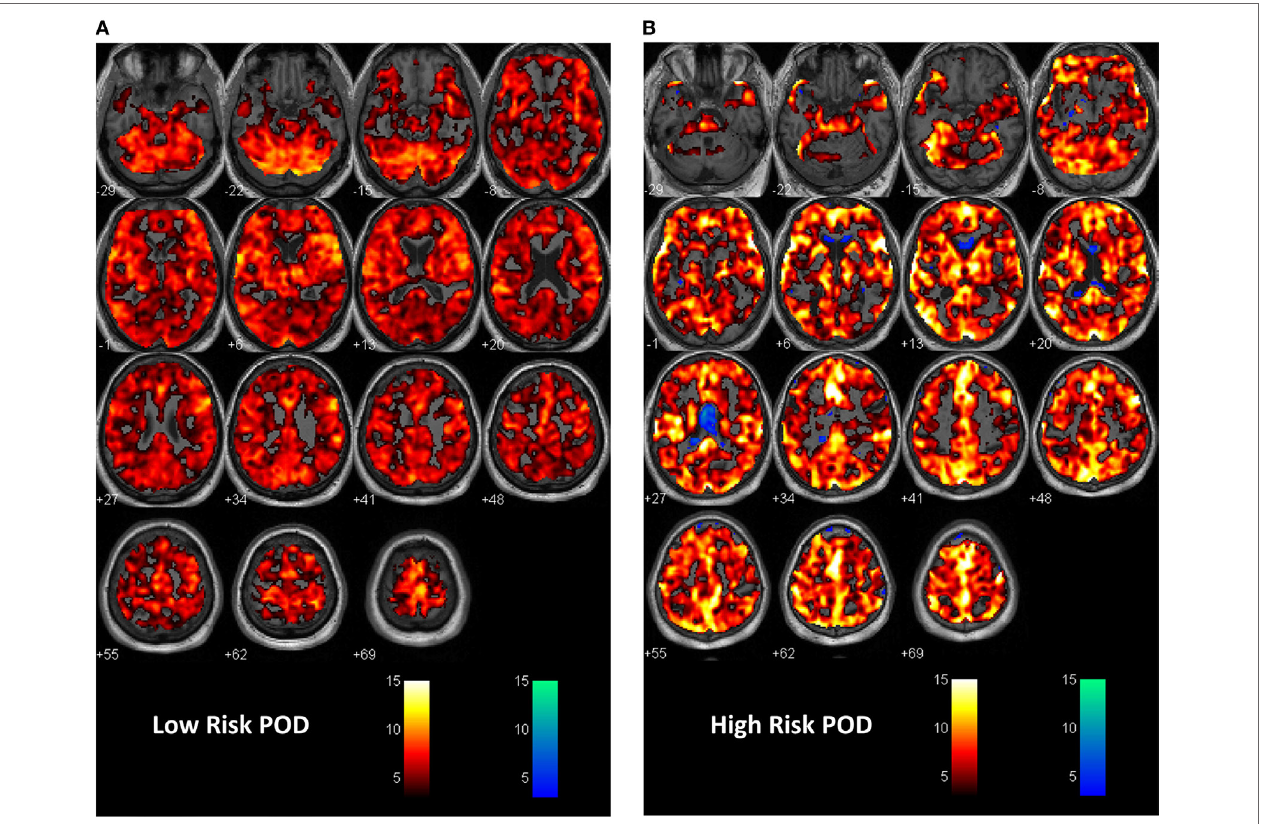
FiGUre 2 | First level analysis with statistical parametric mapping (SPM) showing response to the CO 2 stress test in (A) a patient at low risk for postoperative delirium (POD). In this instance, the expected response to the CO 2 stimulus as recorded during BOLD imaging is shown. A vigorous response to CO 2 is evident from the hot voxel response—shades of orange. The response at the p = 0.001 level occurred in 84% of whole brain parenchyma. The numbers below each image are the distance in millimeters above or below the anterior–posterior commissure. This patient had a non-POD outcome. The color bar is the t -value for fit to the general linear model from the SPM analysis. Voxels are colored if the t -value exceeded 3.11 in this instance. (B) A patient at risk of POD. Here, there is less response to the hypercapnic signal—a 64% response to hypercapnia and now an inverse or intracranial steal signal shown in cold voxels—shades of blue. The inverse voxel count was 4.3% of the total count. This patient had a subthreshold POD outcome. See Ref. (25) for a fuller description of the